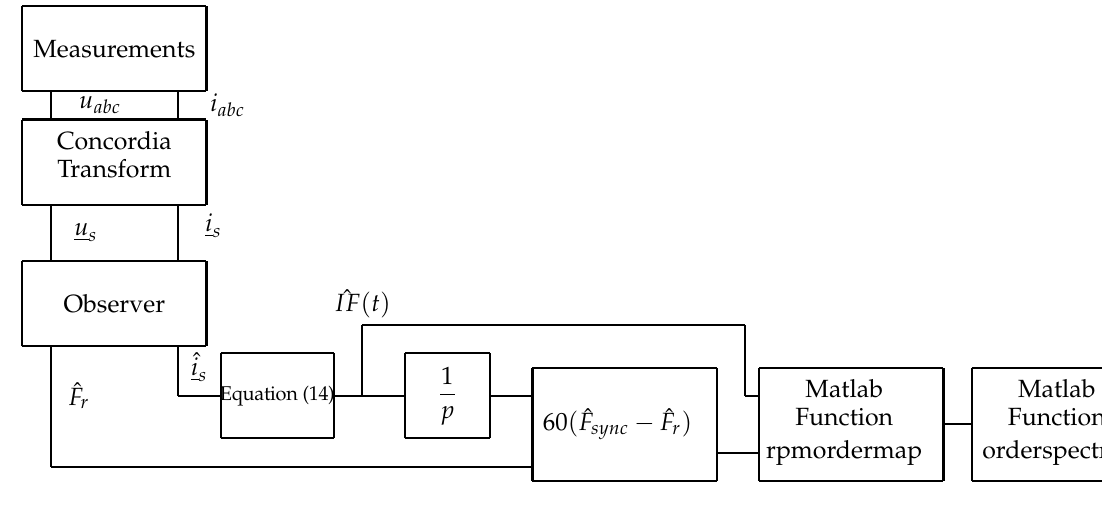
Figure 8. Complete TOT procedure.